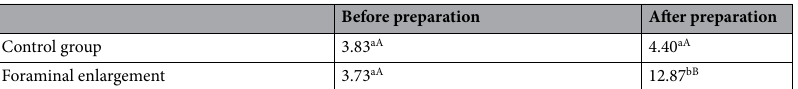
Table 1. Percentage of dentinal microcracks before and after preparation. Different lowercase letters overlapped on the same line indicate statistical difference between before and after preparation in same group. Different capital letters overlapped on the same column indicate statistical difference between groups.